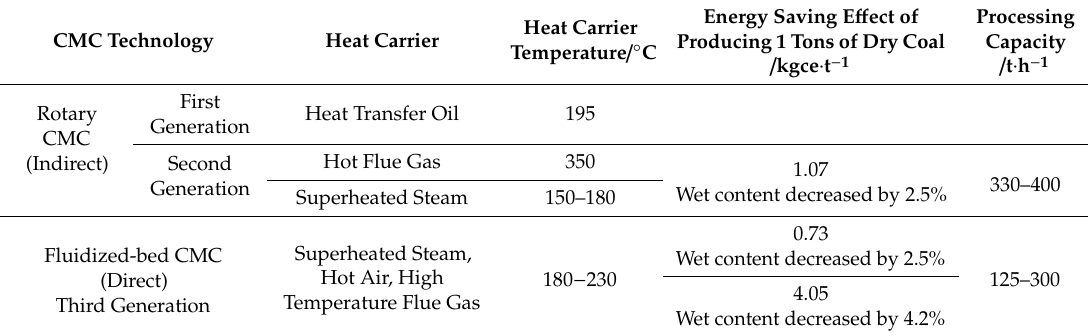
Table 1. Comparison of technical parameters of several CMC